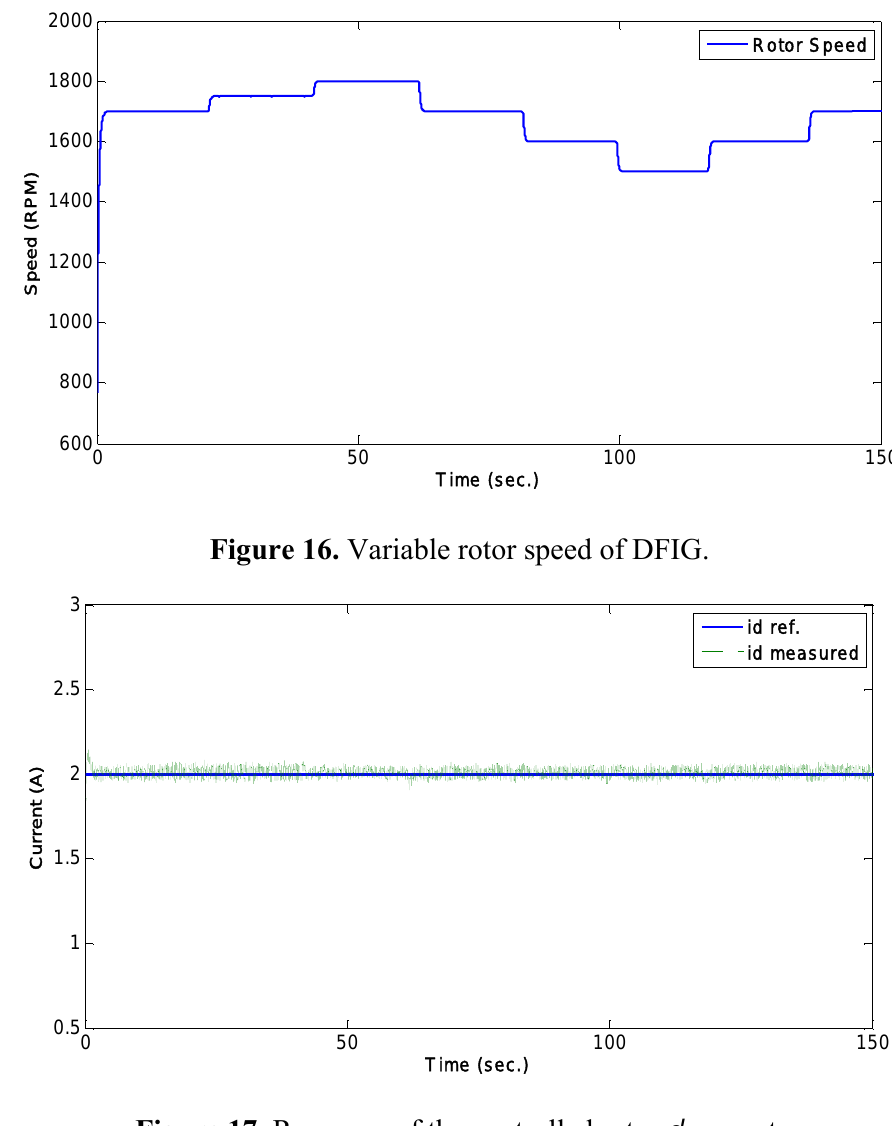
Figure 17. Response of the controlled rotor d -current.